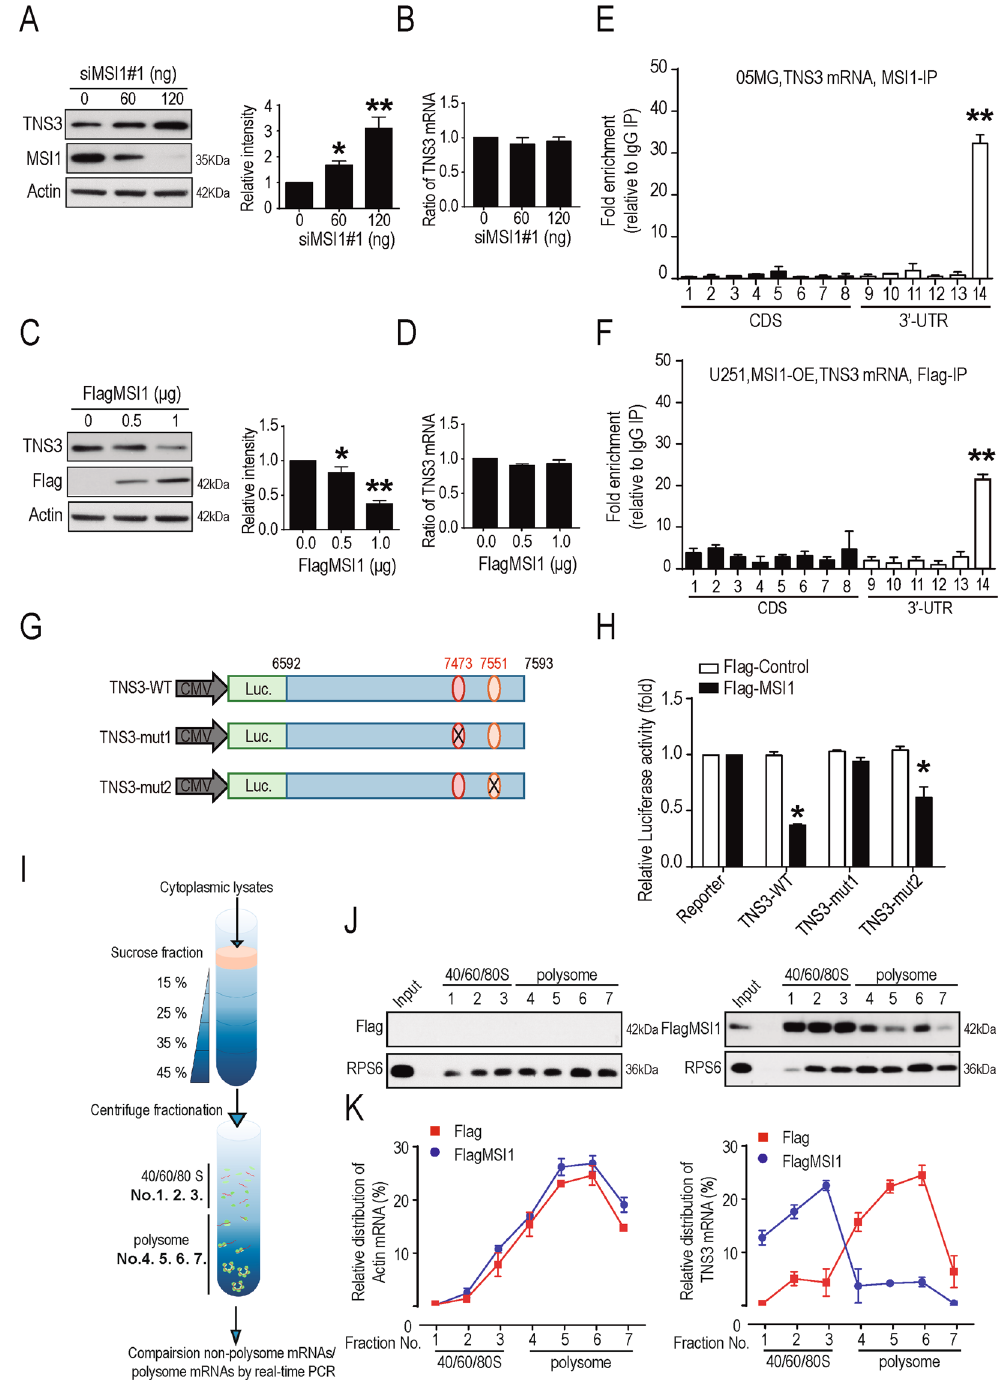
Figure 4. MSI1 repressed TNS3 translation through binding to its 3 ′ UTR. GBM 05MG cells were transiently transfected with 0, 60 and 120 ng of siMSI1. TNS3 and MSI1 expression levels were analyzed 48 hours after transfection by ( A ) Western blotting and ( B ) Real-time PCR. U251 cells were transient transfected with 0, 0.5 and 1 μ g Flag-MSI1. TNS3 and MSI1 expression levels were analyzed 48 hours after transfection by Western blotting (left), and the results were quantified as bar chart (right) and Real-time PCR ( D ). ( E , F ) RNA-ChIP assay was performed in endogenous MSI1 in 05MG cells and exogenous Flag-MSI1 in MSI1-overexpressed U251 cells. The bar chart indicates the gene expression fold change after normalization to IgG-precipitated controls. ( G ) Schematic representation of the reporter constructs containing the firefly luciferase fused to wild-type or mutated TNS3-3 ′ UTR. ( H ) Luciferase reporter assays were conducted in U251 cells with or without MSI1 expression. The bioluminescent signal of each TNS3-3 ′ UTR reporter were shown as relative fold change to their respective luciferase positive control. ( I ) Schematic illustration showing the sucrose gradient centrifugation. The gradient used in this study was 15% at the top and 45% at the bottom. Whole-cell lysates